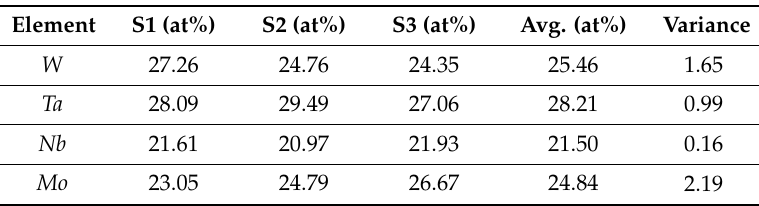
Table 1. Compositions of samples.